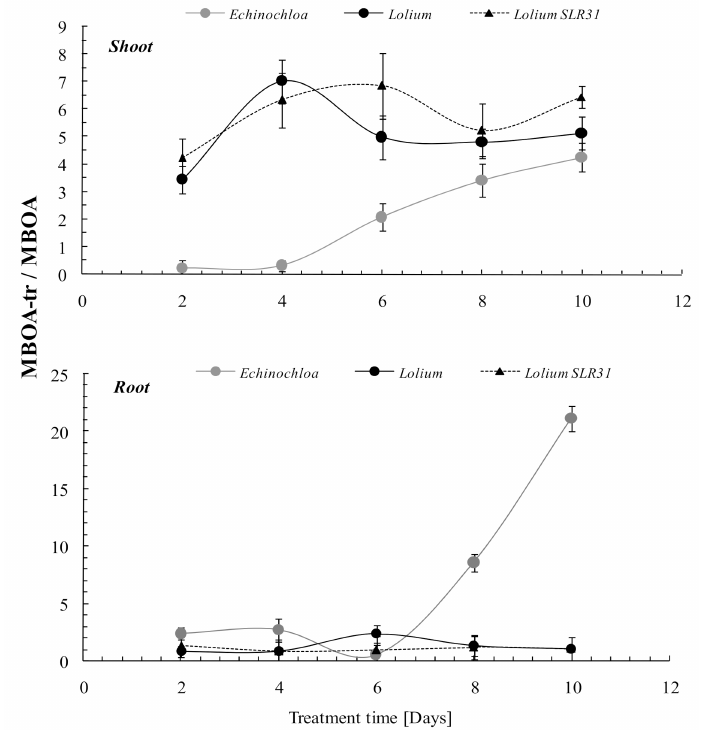
Figure 3. [MBOA-tr]/[MBOA] ratio in root extract of Echinochloa crus-galli, Lolium rigidum L and Lolium rigidum SLR31 at various treatment times. [MBOA] = 3 mM. Error bars represent standard deviation for n =